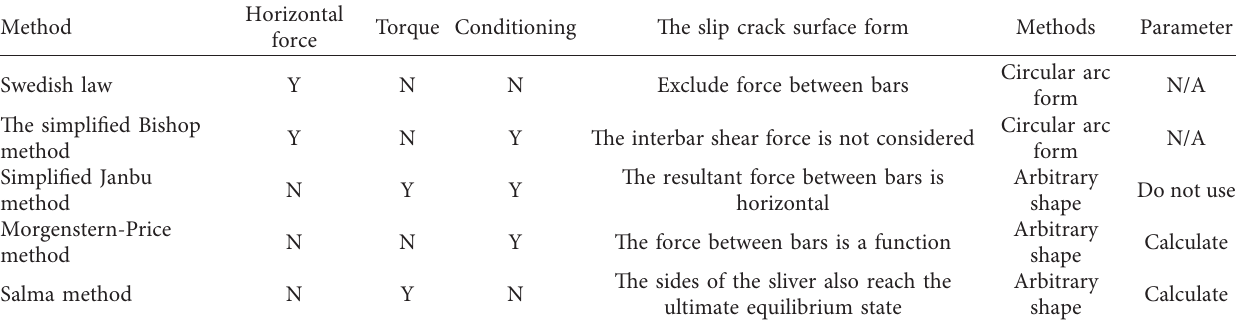
Table 1: The comparison of various limit equilibrium methods